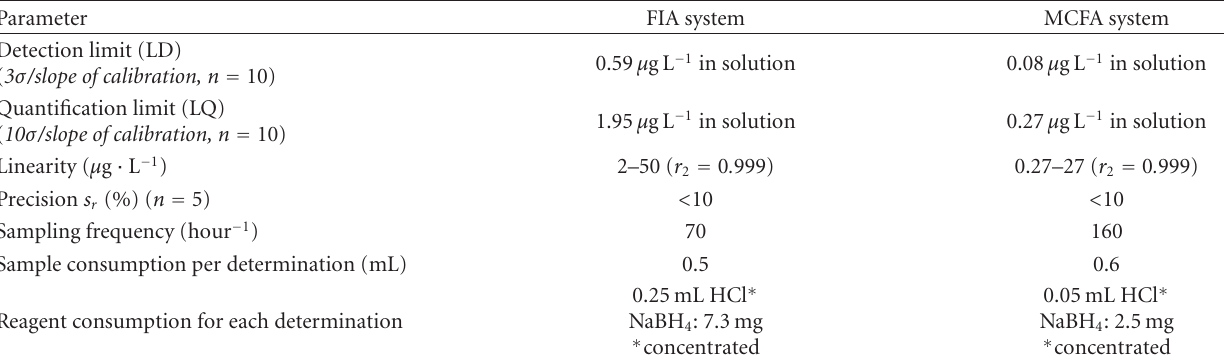
Table 4: Figures of merit: comparison of performance of the FIA and MCFA flow systems.